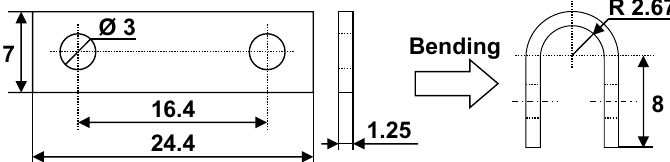
Figure 1. Dimensions of a U-bend specimen for the stress corrosion cracking (SCC) tests (unit: mm).